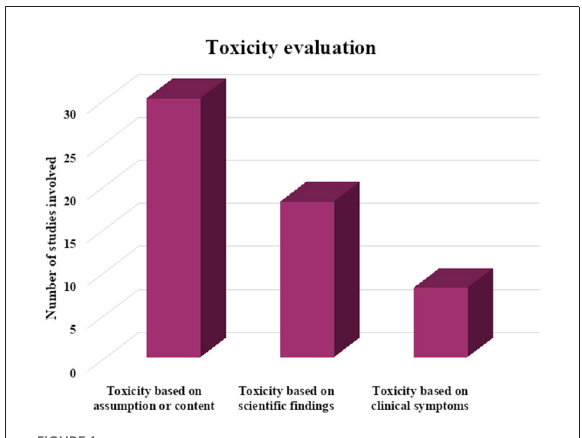
FIGURE1 The bases of toxicity of geophagic material in reviewed